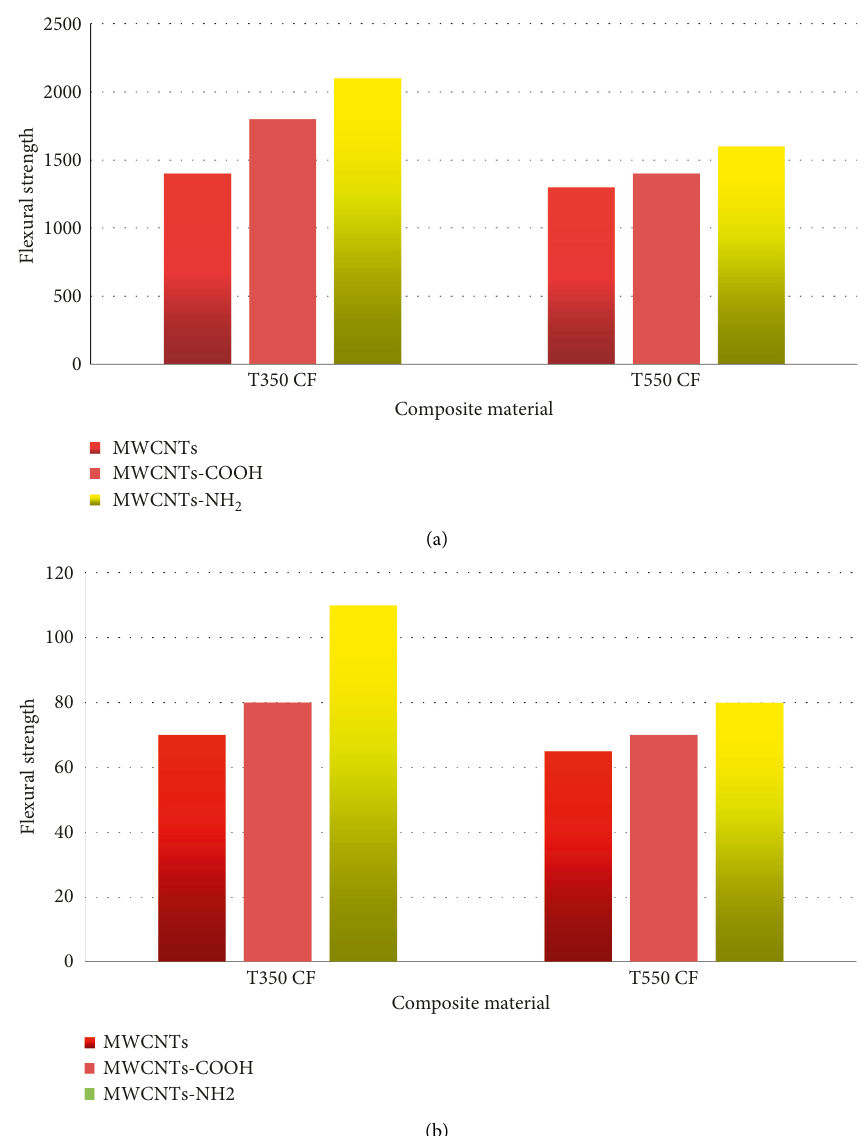
Figure 7: Comparison of flexural strength and flexural modulus of composites with different contents of carbon fiber. (a) Bending strength. (b) Flexural